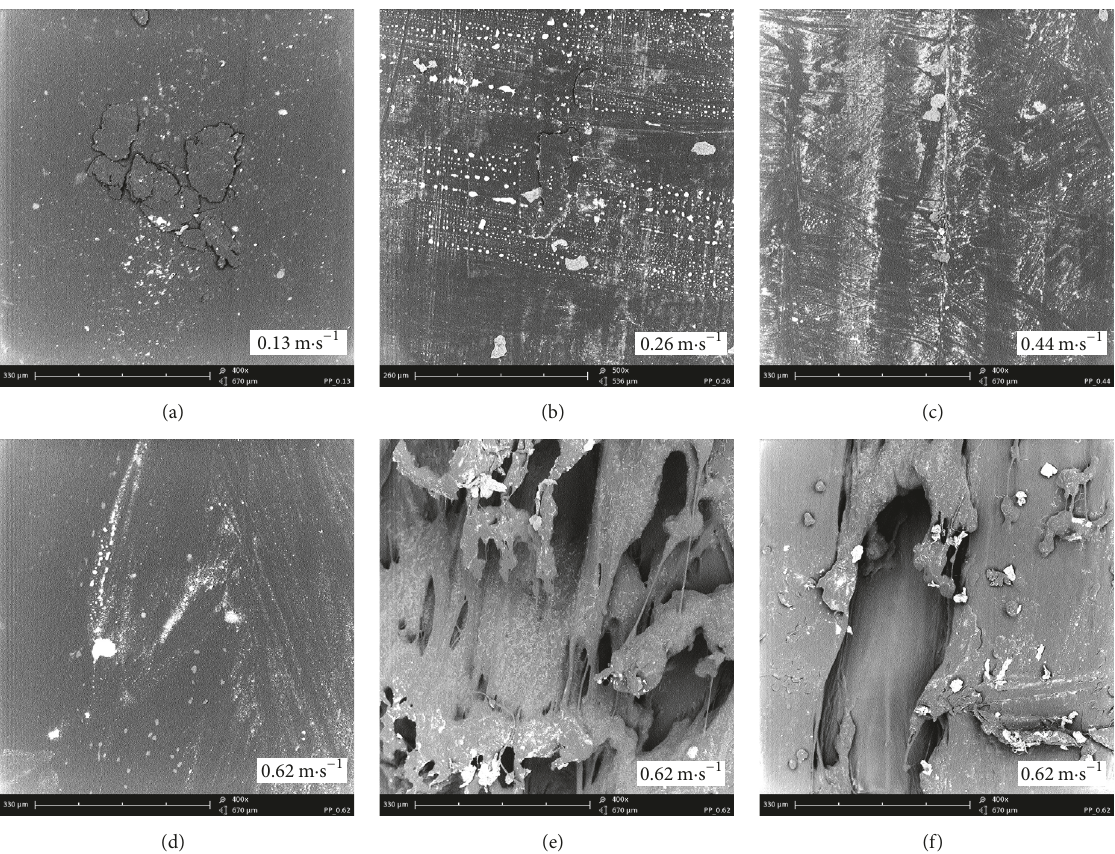
Figure 13: Effect of sliding velocity on worn surfaces of the investigated PA 6.6: ((a) and (b)) shallow scratches and wear traces of adhesive nature; (c) scratches and cracks on the surface; (d) smooth zone with dominating adhesion and microcutting; (e) zone with fracture; bridges with plastically deformed pores between them; (f) zone with fracture, SEM.